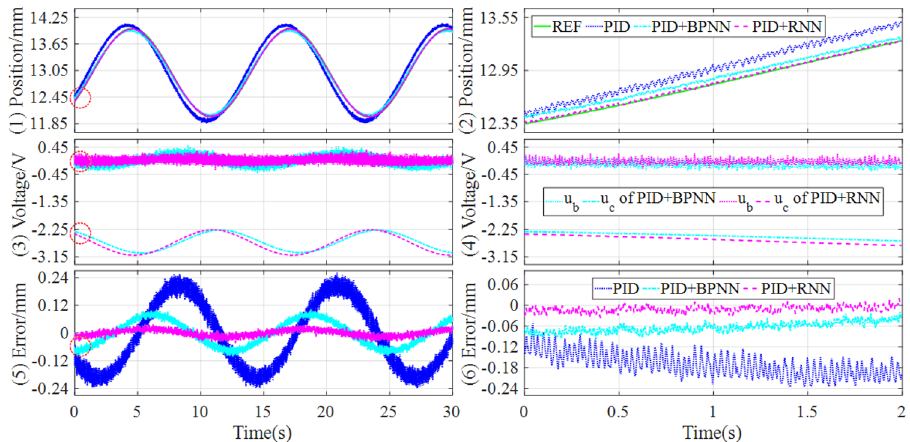
Figure 13. Experimental results of tracking sinusoidal signal under the different controllers.